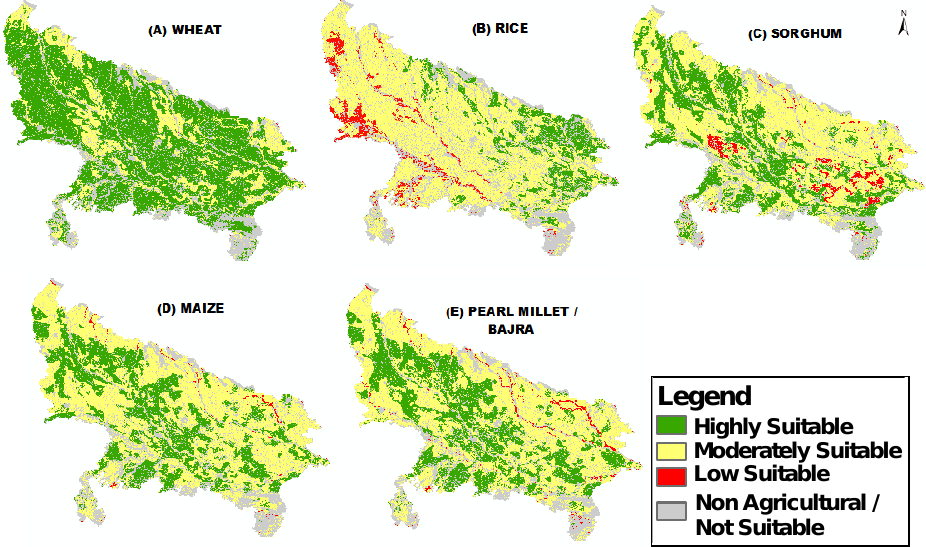
Figure 4. Cereal Crop Suitability Map of Uttar Pradesh (A) Wheat, (B) Rice, (C) Sorghum, (D) Maize, (E) Pearl Millet / Bajra CEREAL CROPS